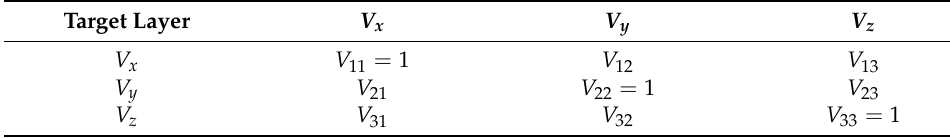
Table 2. 3D judgment matrix of concrete corrosion